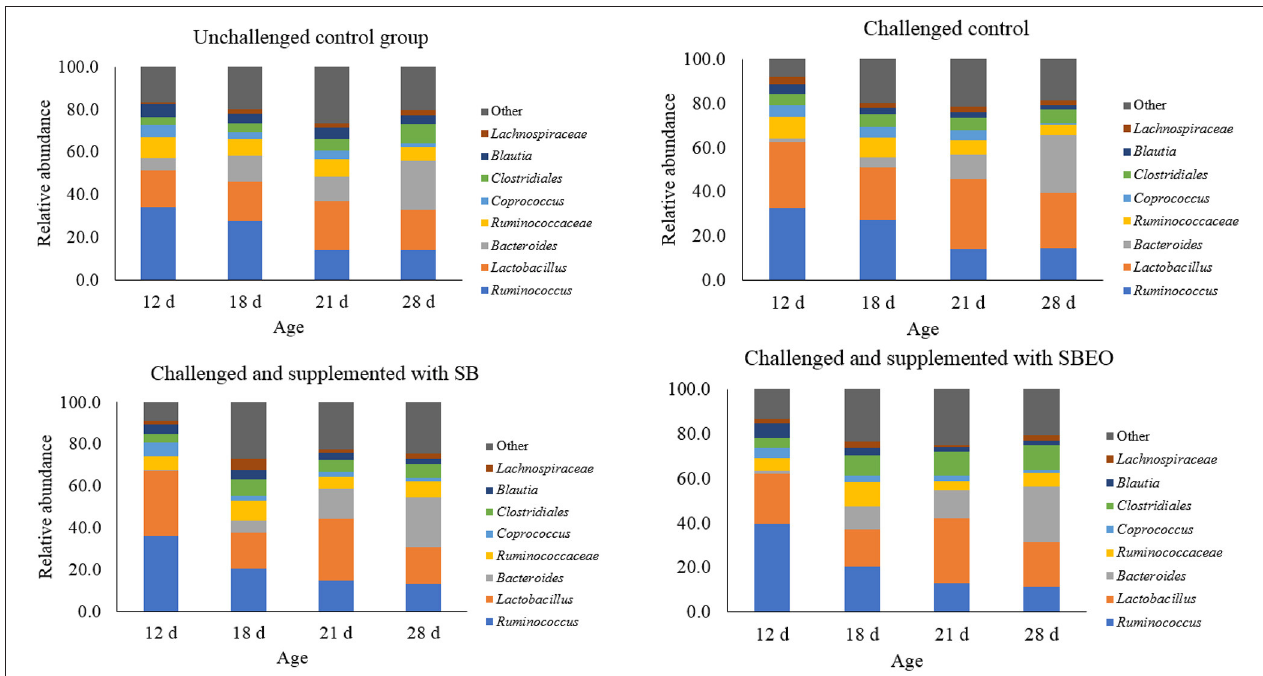
FIGURE 2 | Relative abundance (%) of the main bacterial group present in the cecal microbiota of broiler chickens in different timepoints within each experimental treatment (Values are means of 8 replicates and a pool of 2 birds/replicate). SB, Sodium butyrate; SBEO, Sodium butyrate plus essential oils.